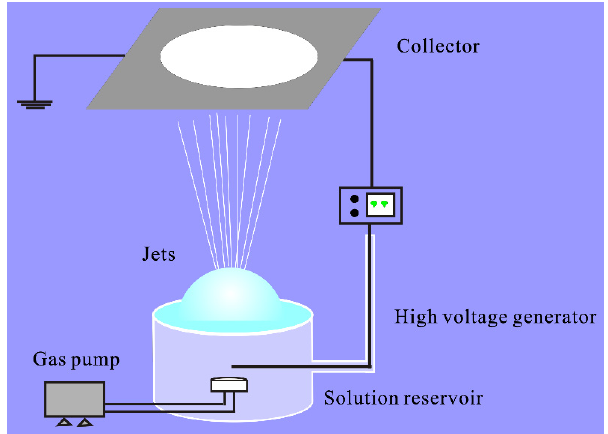
Figure 1. Schematic illustration of the critical bubble electrospinning.